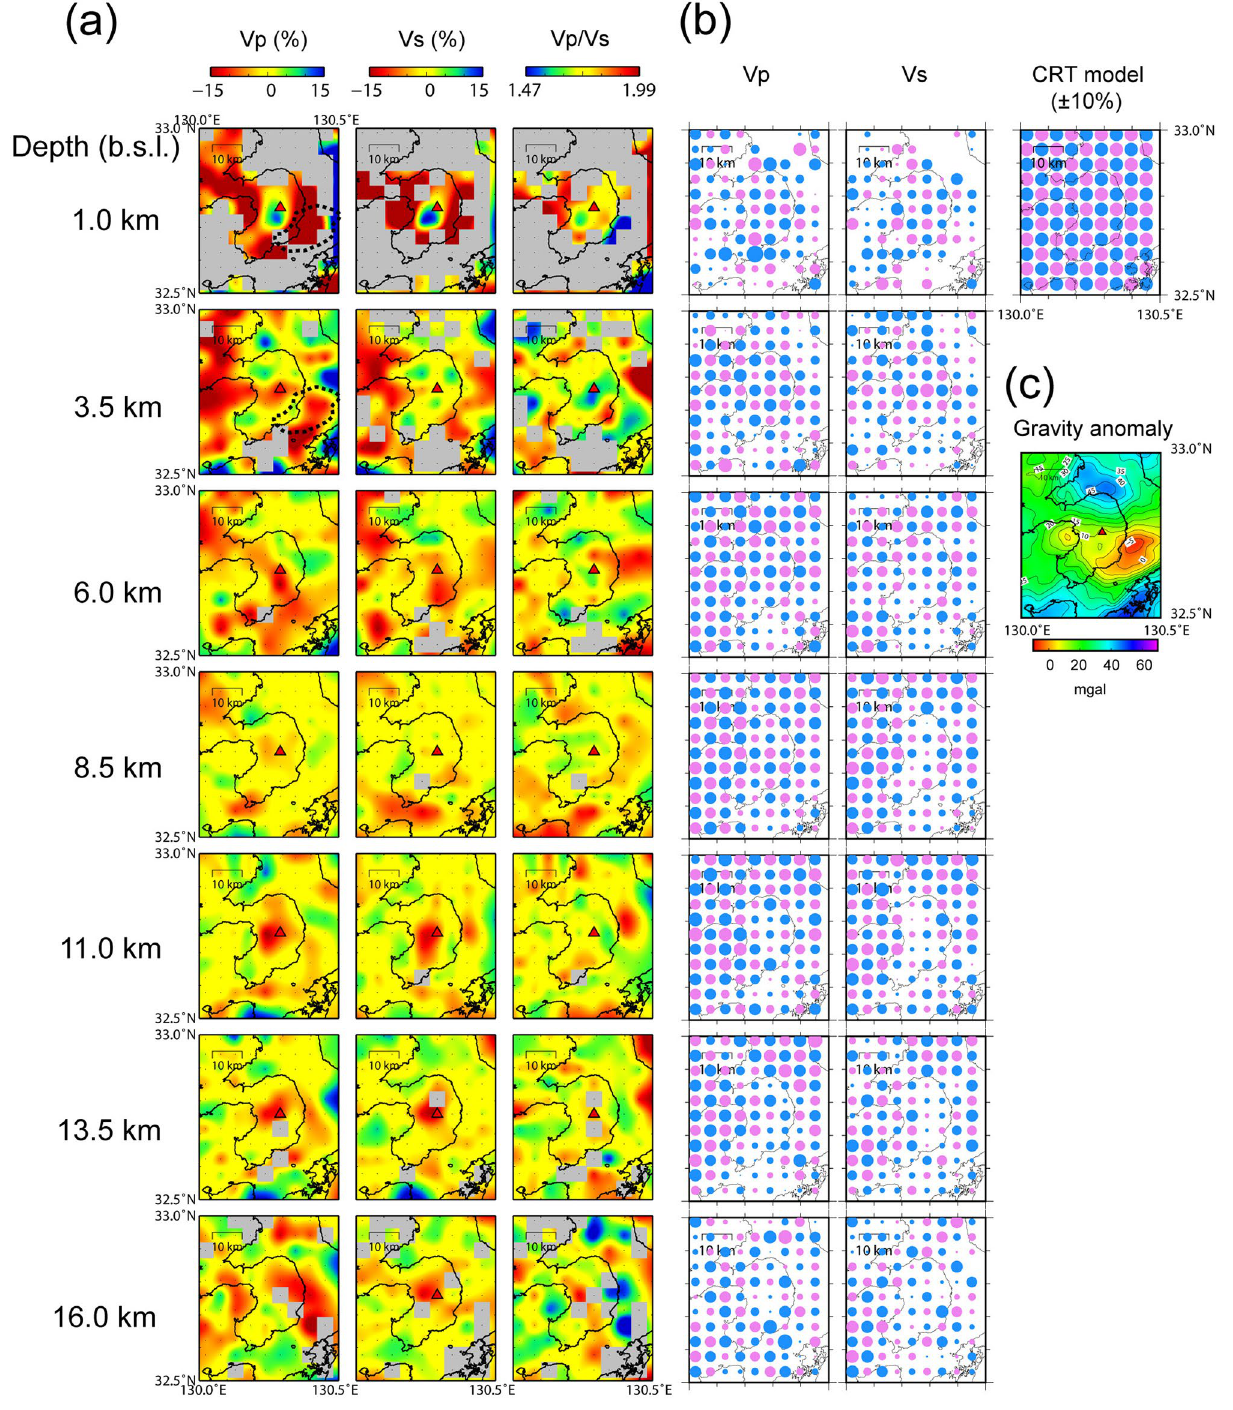
Figure 4. Maps showing the velocity structure and gravity anomaly. (a) Horizontal slices of P-wave, S-wave, and Vp/Vs perturbations at various depths (beneath sea level, b.s.l.). The images were created by interpolation of model parameters solved at the grid points shown in Fig. 2a. Perturbations were calculated as the deviation from the DWS weighted averaged 1D structure (Fig. 3). Areas with resolvability values of < 0.65 are masked (gray). The low gravity zone shown in (c) is marked by a black dashed line at Vp structure 1 and 3.5 km b.s.l. (b) Result of a checkerboard resolution test (CRT). The area of each circle is proportional to the recovery rate from the initial checkerboard pattern (± 10%). (c) Bouguer gravity anomaly assuming a terrain density of 2.63 g/cm 3 . The contour interval is 5 mgal. The low-gravity zones are well correlated with the low-Vp zone at 3 and 6 km b.s.l. Other notations are the same as in Figs. 1 and 3. Gravity data for the gravity basemaps are used under copyright from the Geospatial Information Authority of Japan (GSI); the map is licensed under the Creative Commons Attribution 2.1 Japan License. The Bouguer anomaly map was compiled using a database from AIST (Geological Survey of Japan AIST